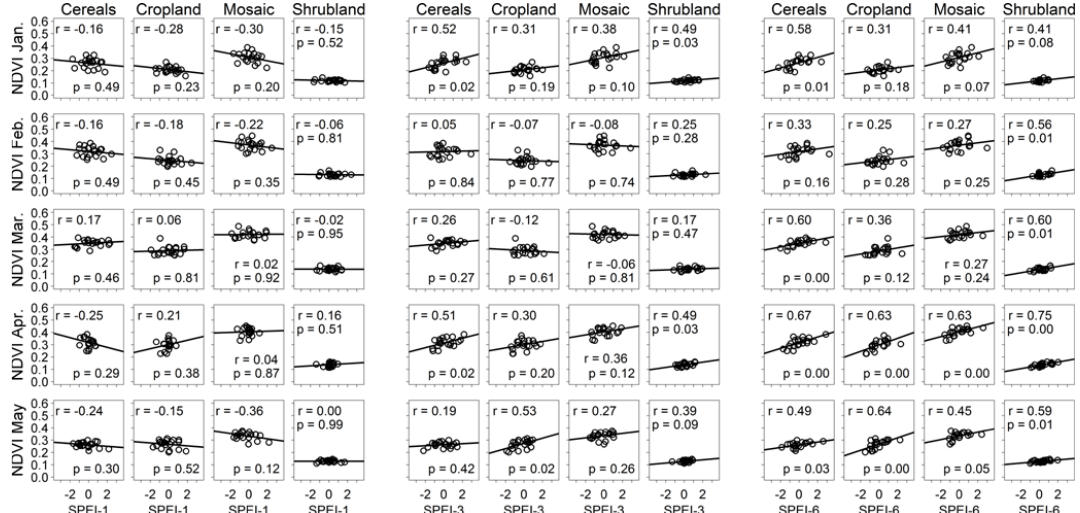
Fig. 4. Scatterplots between NDVI and multiple timescales of SPEI for chosen land uses. Each dot represents one year between 1982 and 2001. Also shown are the correlation coefficient r and the p value.